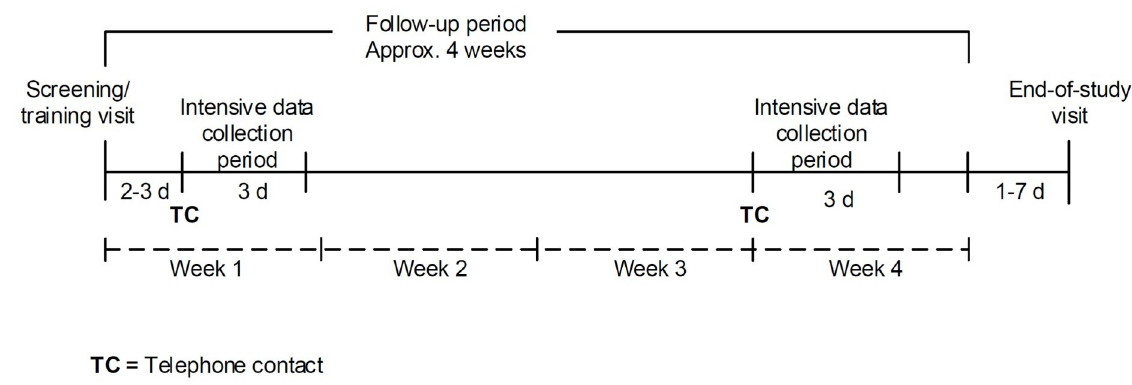
Fig 1. The Study